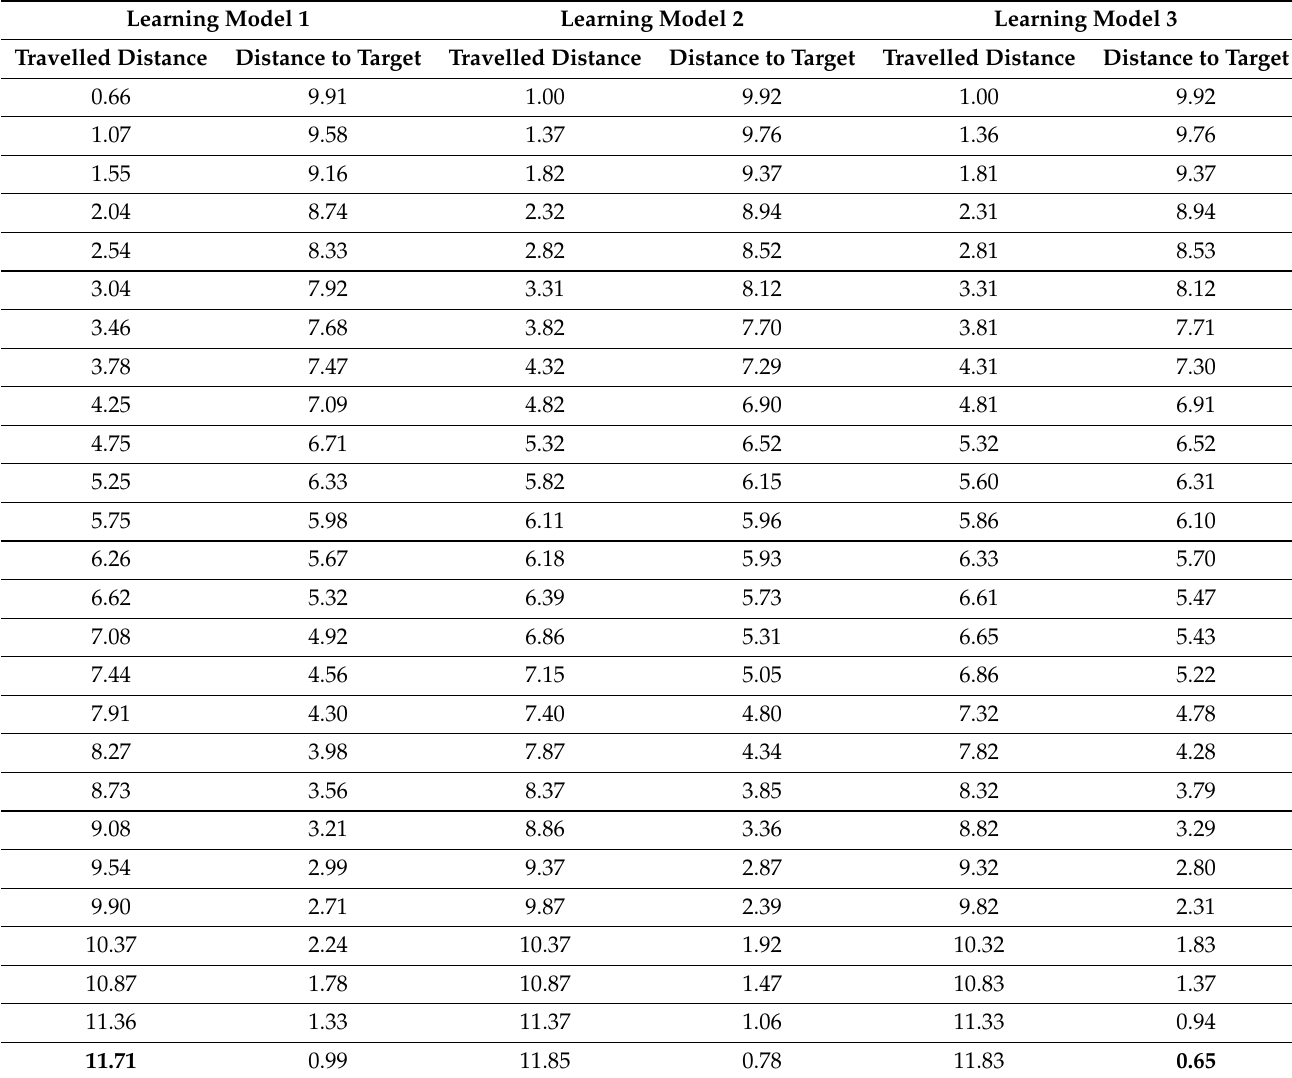
Table 6. Comparison between learning